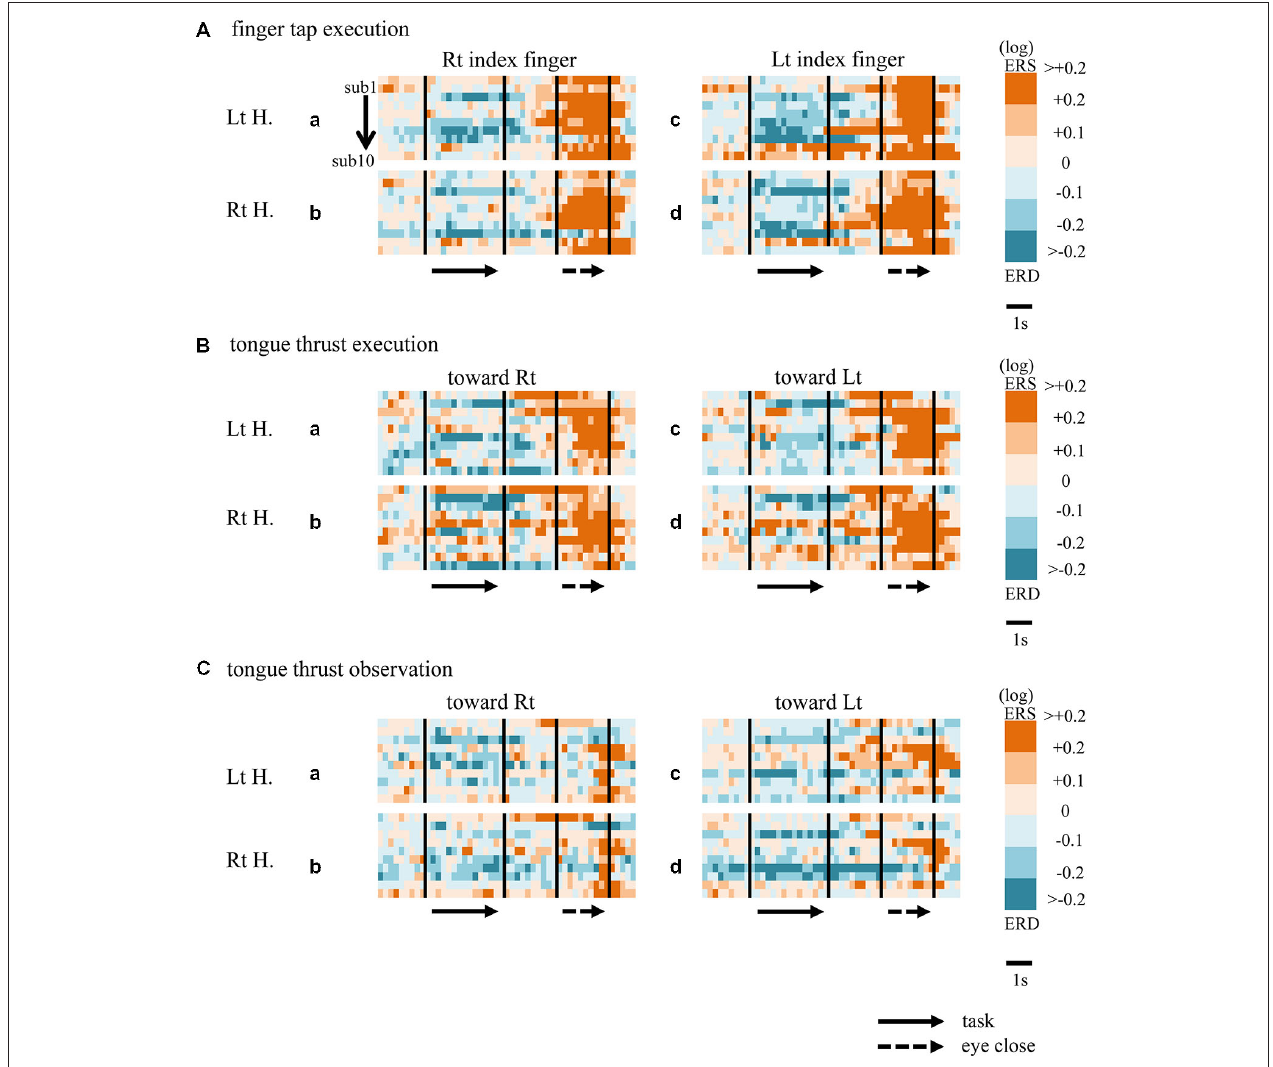
FIGURE 5 | Matrix chart of mu rhythm ERD/ERS from all ten participants (sub1 − sub10) . ERD indicated by light/deep blue, ERS by orange/red. Matrices are for finger tap execution (A) , tongue thrust execution (B) , and tongue thrust observation (C) . H, hemisphere; Lt, left; Rt,